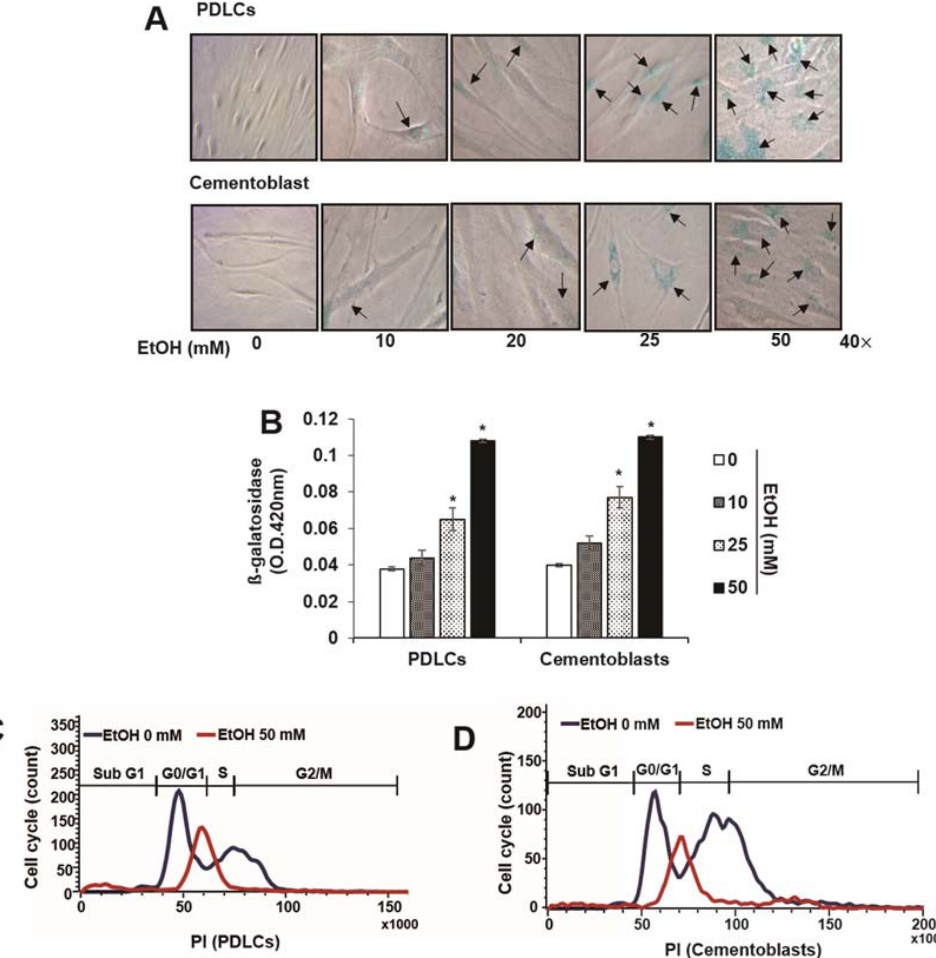
Figure 2. Effect of ethyl alcohol (EtOH) on characterization of cellular senescence by senescence-associated β -galactosidase ( β -gal) staining ( A ), β -gal activity ( B ), cell cycle analysis ( C , D ) and expression of senescence-associated proteins ( E ) in periodontal ligament cells (PDLCs) and cementoblasts. Cells are incubated with indicated concentration of EtOH for 3 days ( A – E ); ( A , B ) SA- β -Gal activity was evaluated using a staining kit. Cell cycle and protein analysis were assessed by flow cytometry ( C , D ) and Western blot ( E ), respectively. Flow-cytometric frequency histograms of progenitors stained with propidium iodide (PI) for DNA content. These data are representative of three independent experiments. *: statistically significant difference compared to the control groups ( p < 0.05). Arrows in Figure 2A represent β -gal (+) cells.